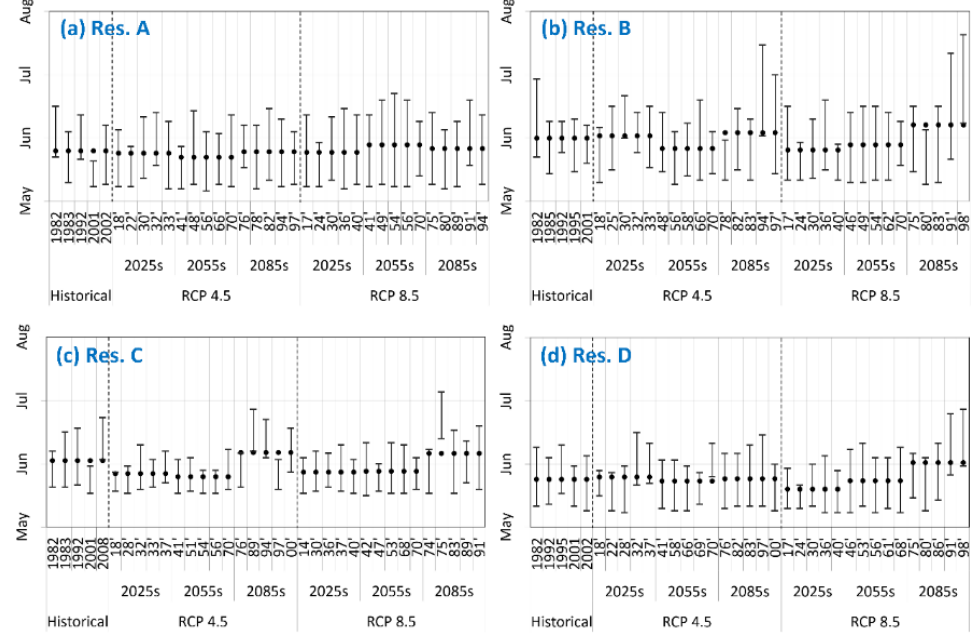
Figure 10. Temporal shifts in irrigation vulnerable seasons between the historical period and future period in the agricultural reservoirs: (a) Res. A, (b) Res. B, (c) Res. C, (d) Res. D.